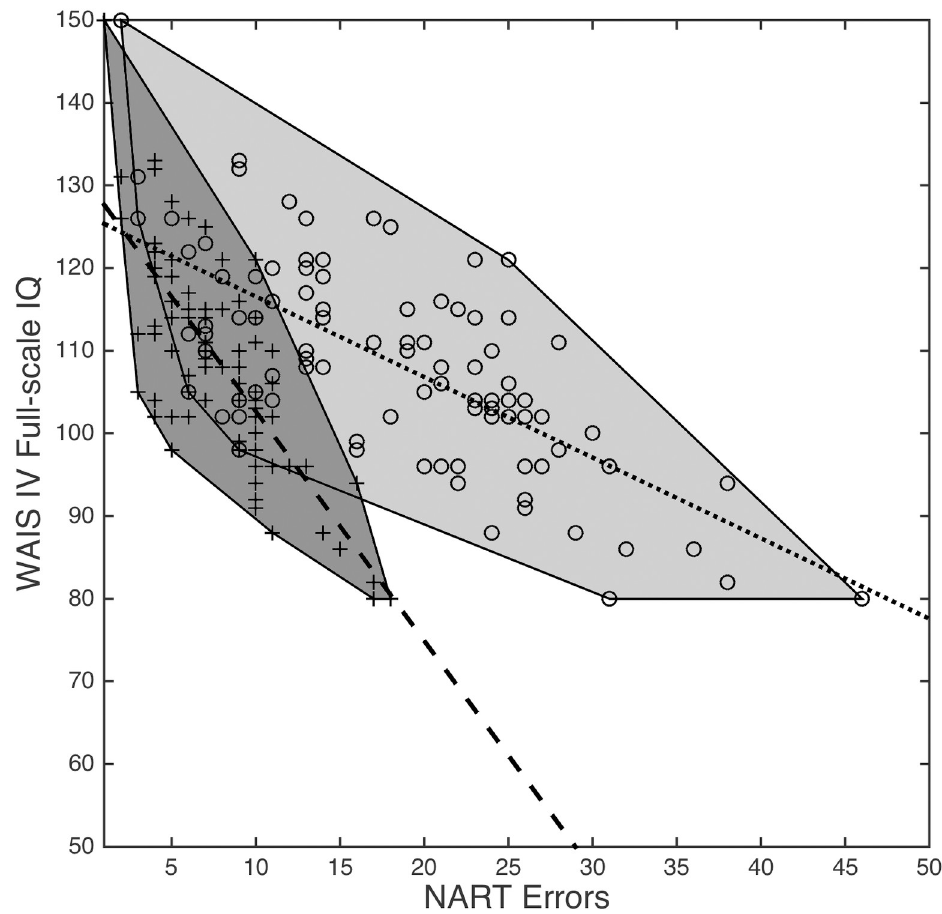
Fig 3. Scatterplot of NART errors vs . WAIS-IV FSIQ using original (sample points denoted � , line equation dotted, light gray convex hull) and GA-derived (sample points denoted +, line equation dashed, dark gray convex hull)